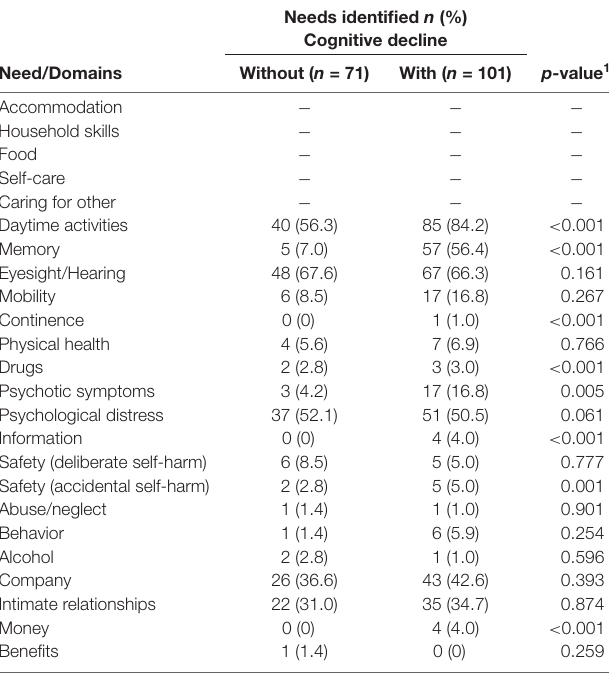
TABLE 4 | Unmet needs considering cognitive decline